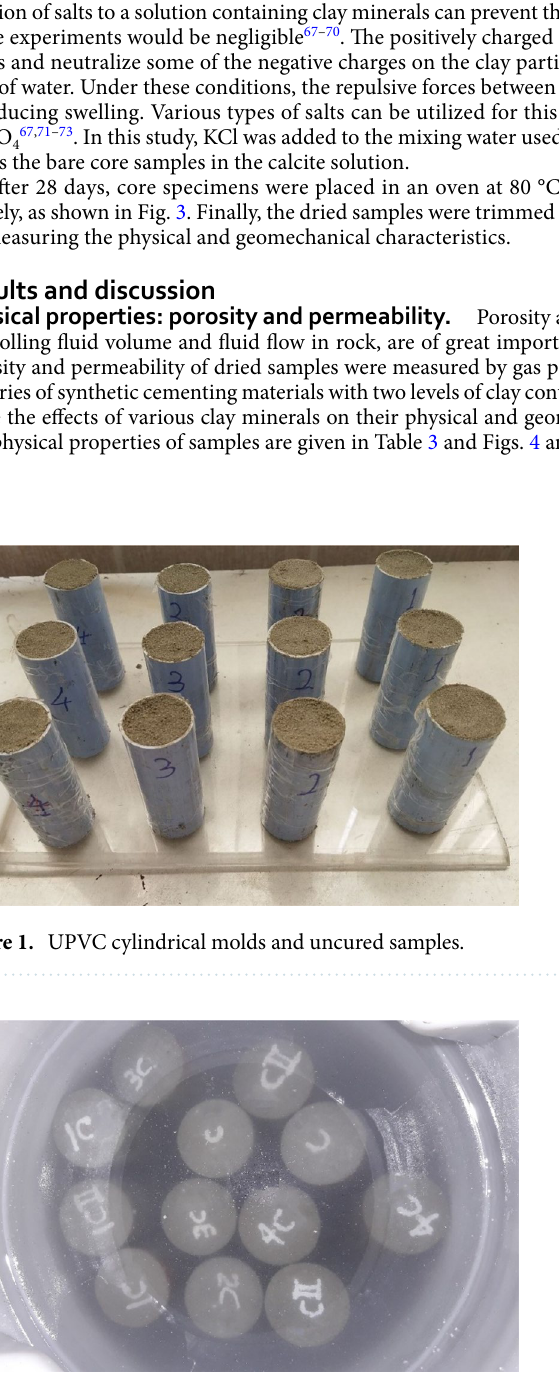
Figure 2. Bare core samples in the calcite